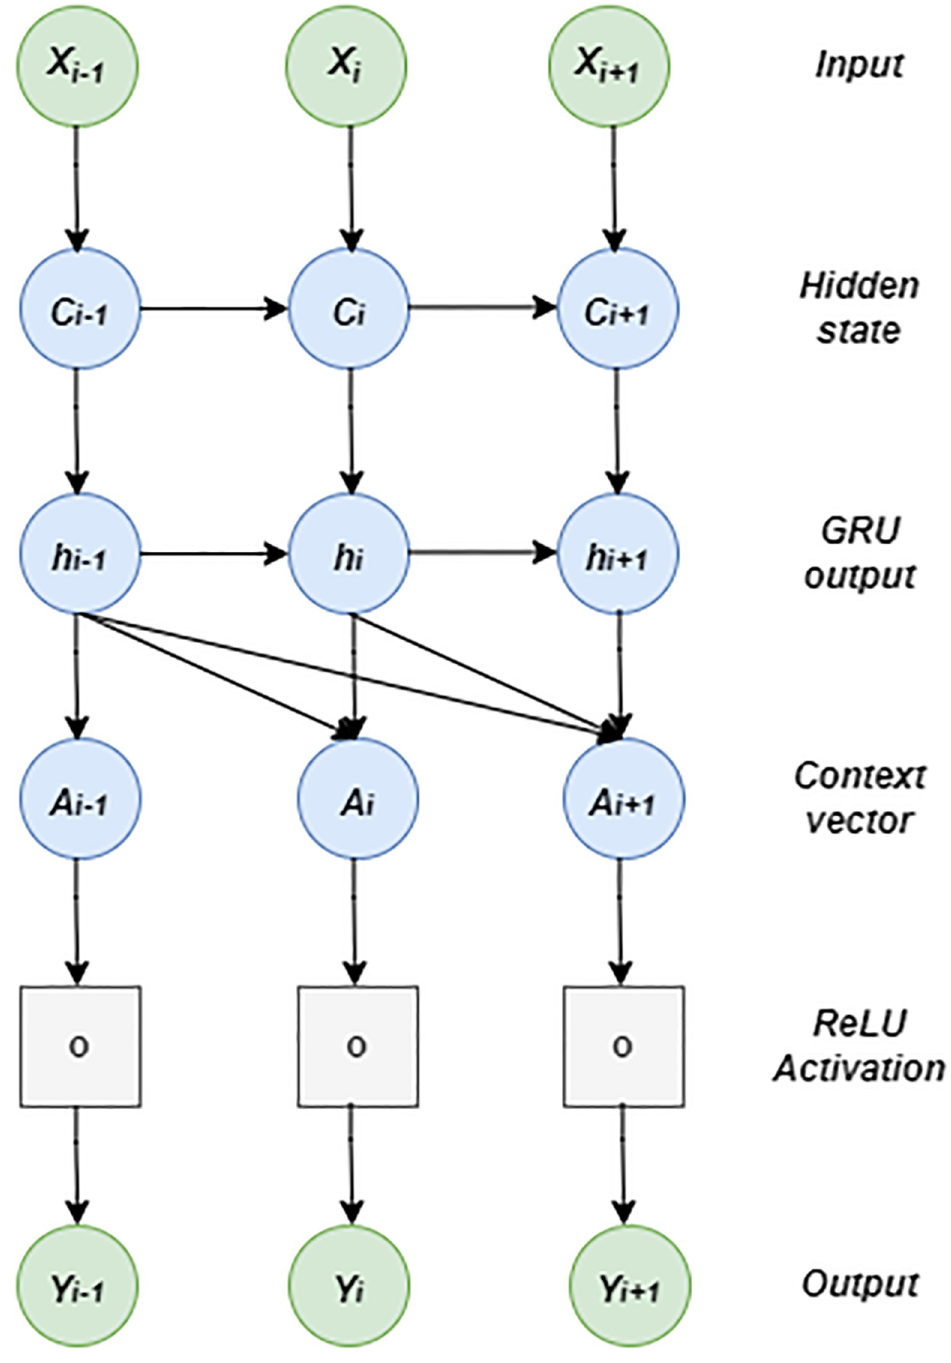
Fig 3. Data flow of proposed GRU